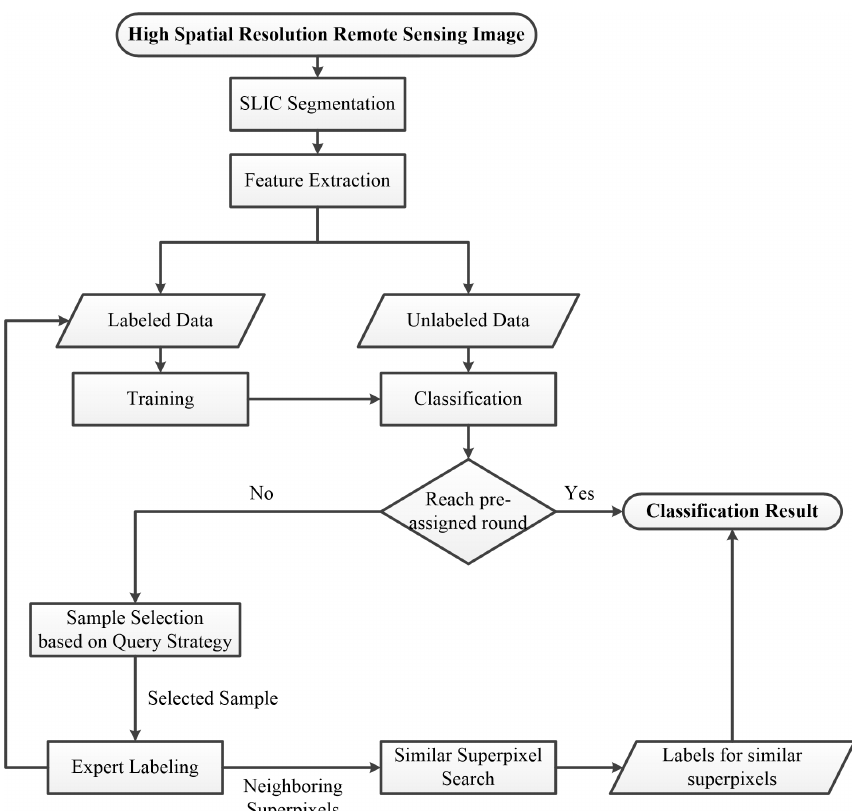
Figure 3. Flowchart of the proposed classification